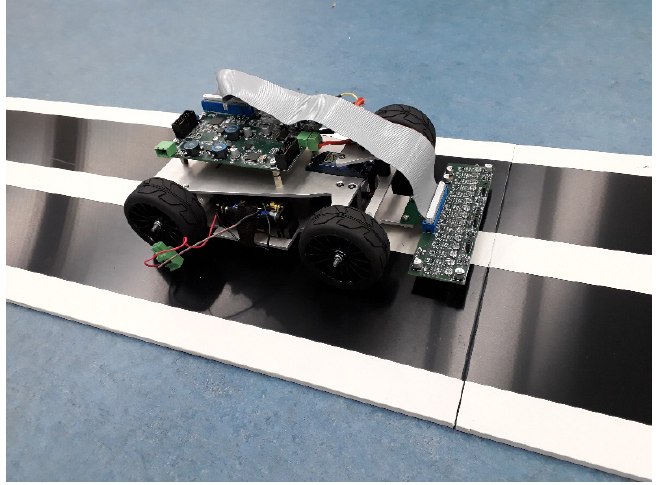
Fig. 2. Model car on test